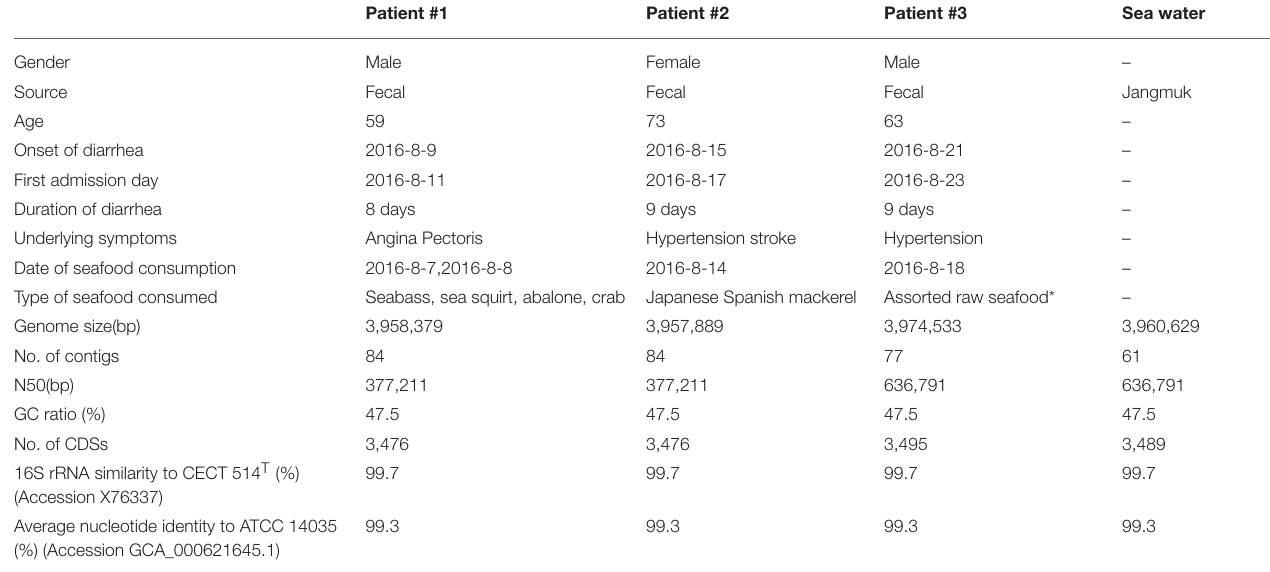
TABLE 1 | Patient information and genomic properties of V. cholerae